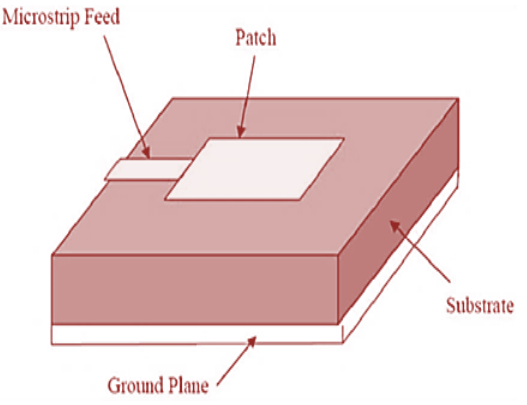
Figure 1: Components of MSA